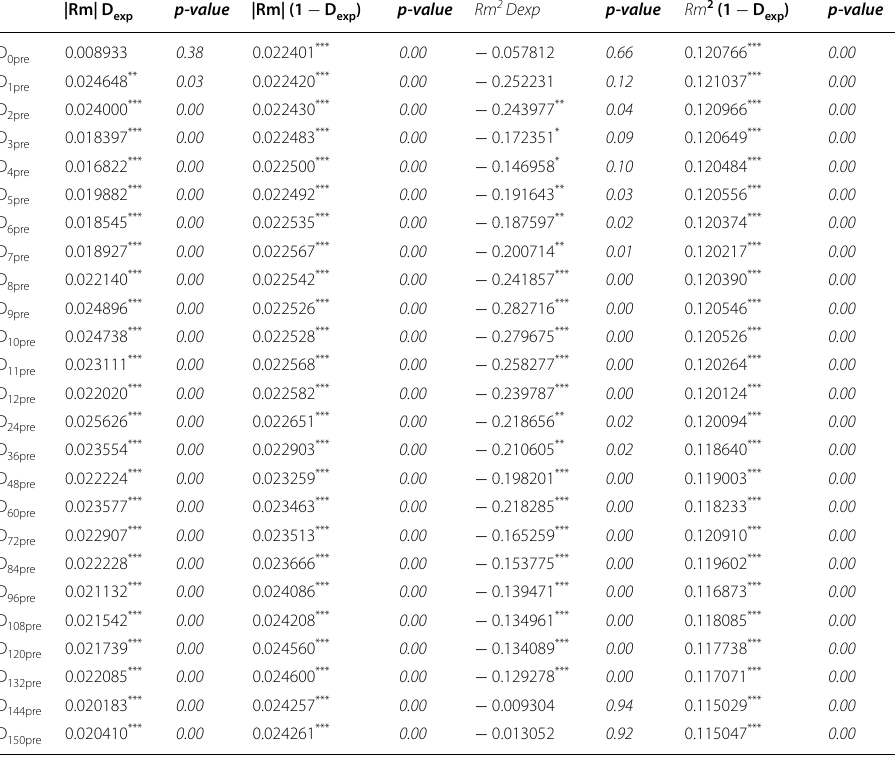
Table 3 Conditional hourly herding around the expiration. Effects before